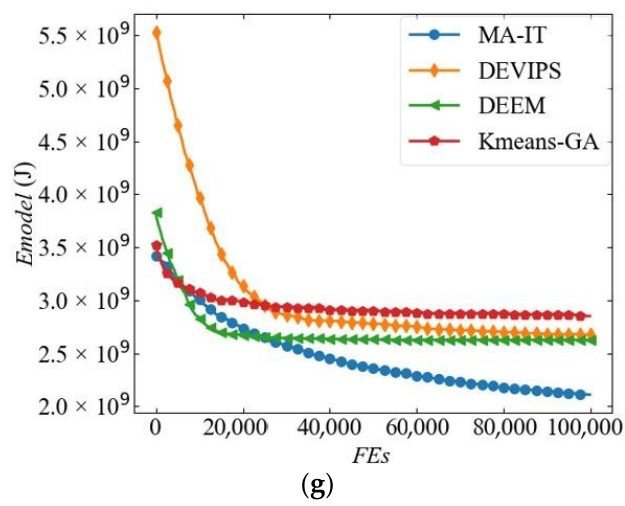
Figure 7. The convergence graphs of all algorithms in different instances. ( a ) N = 100, ( b ) N = 200, ( c ) N = 300, ( d ) N = 400, ( e ) N = 500, ( f ) N = 600, and ( g ) N = 700.